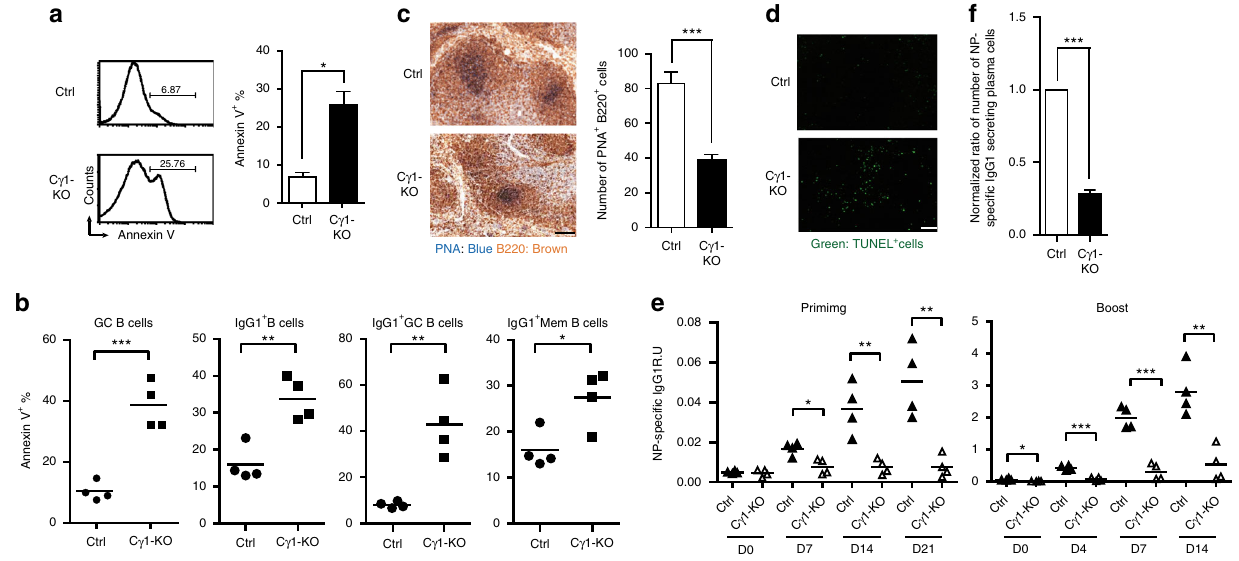
Fig. 5 Mice lacking Ogt in post-GC B cells do not activate antibody responses. a Flow cytometric analysis of the frequency of Annexin V + cells in Ctrl and C γ 1-KO splenic B cells stimulated with anti-IgM (25 µ g ml − 1 ), anti-CD40 (1 μ g ml − 1 ) and IL-21 (200 ng ml − 1 ) for 2 days. Quanti fi cation of results is shown in the right panel. b The frequency of apoptotic GC B cells (GL7 + CD38 lo ), IgG1 + B cells, IgG1 + GC B cells (IgG1 + GL7 + CD38 lo ) and IgG1 + memory B cells (IgG1 + GL7 − CD38 hi ) were examined by Annexin V staining at 14 days after NP-KLH immunization. c Immunohistochemistry staining with anti-B220 and peanut agglutinin (PNA) lectin on spleen sections of Ctrl and C γ 1-KO mice 14 days after immunization. Scale bar = 100 µ m. Quanti fi cation of results is shown in the right panel. d TUNEL assay using the embedded spleen sections from c showing increased apoptotic cells in immunized C γ 1-KO mice. Scale bar = 50 µ m. e The levels of NP-speci fi c IgG1 in Ctrl and C γ 1-KO mice after primary and secondary NP-KLH immunization at indicated days were analyzed by ELISA. f ELISPOT analysis of the number of plasma cells secreting anti-NP IgG1 in the bone marrow of Ctrl and C γ 1-KO mice 4 weeks after secondary NP-KLH immunization. The data in a , b , c , e and f are the mean ± s.e.m. (data are based on 3 pairs of mice in a , and 4 pairs of mice in b , c , e and f ; in c , 5 GCs were randomly selected for counting). Representative data from one of at least two experimental repeats are shown. * P < 0.05, ** P < 0.01, *** P < 0.001 (two-tailed unpaired t